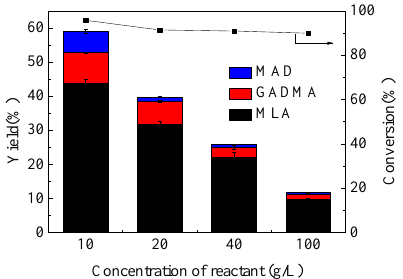
Figure 6. Effect of concentration of reactant on the conversion of HFCS-55. Reaction conditions: methanol, 6 mL; c-Co 0.25 , 0.03 g; 180 °C; 18 h.